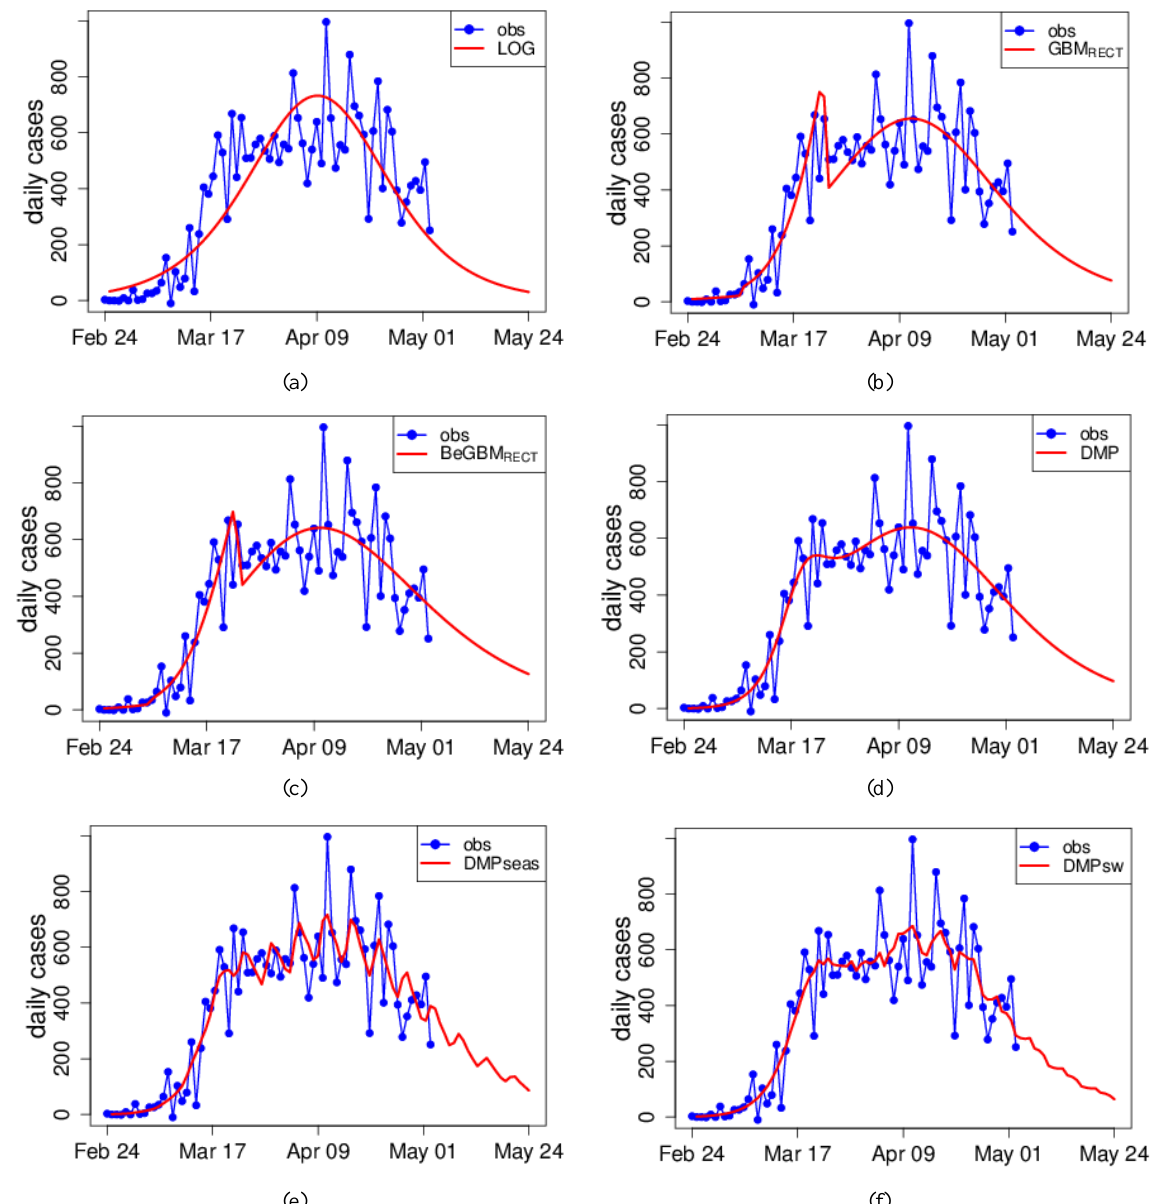
Figure 7. Piedmont. Observed and fitted values with the alternative models. (a) Logistic (LOG); (b) GBM with rectangular shock (GBM 𝑹𝑬𝑪𝑻 ); (c) Bemmaor GBM with rectangular shock (BeGBM 𝑹𝑬𝑪𝑻 ); (d) Dynamic market potential (DMP); (e) Dynamic market potential+seasonal effect (DMPseas); (f) Dynamic market potential+swabs (DMPsw). Table 5. Piedmont. Estimates, asymptotic standard errors and 95% mCIs for the parameters of the DMPsw (9)+(11). Parameter Estimate Standard Error Confidence Interval 𝑚 31620.64 323.5048 (30974.37, 32266.92) 𝑝 𝑐 0.000056 0.000014